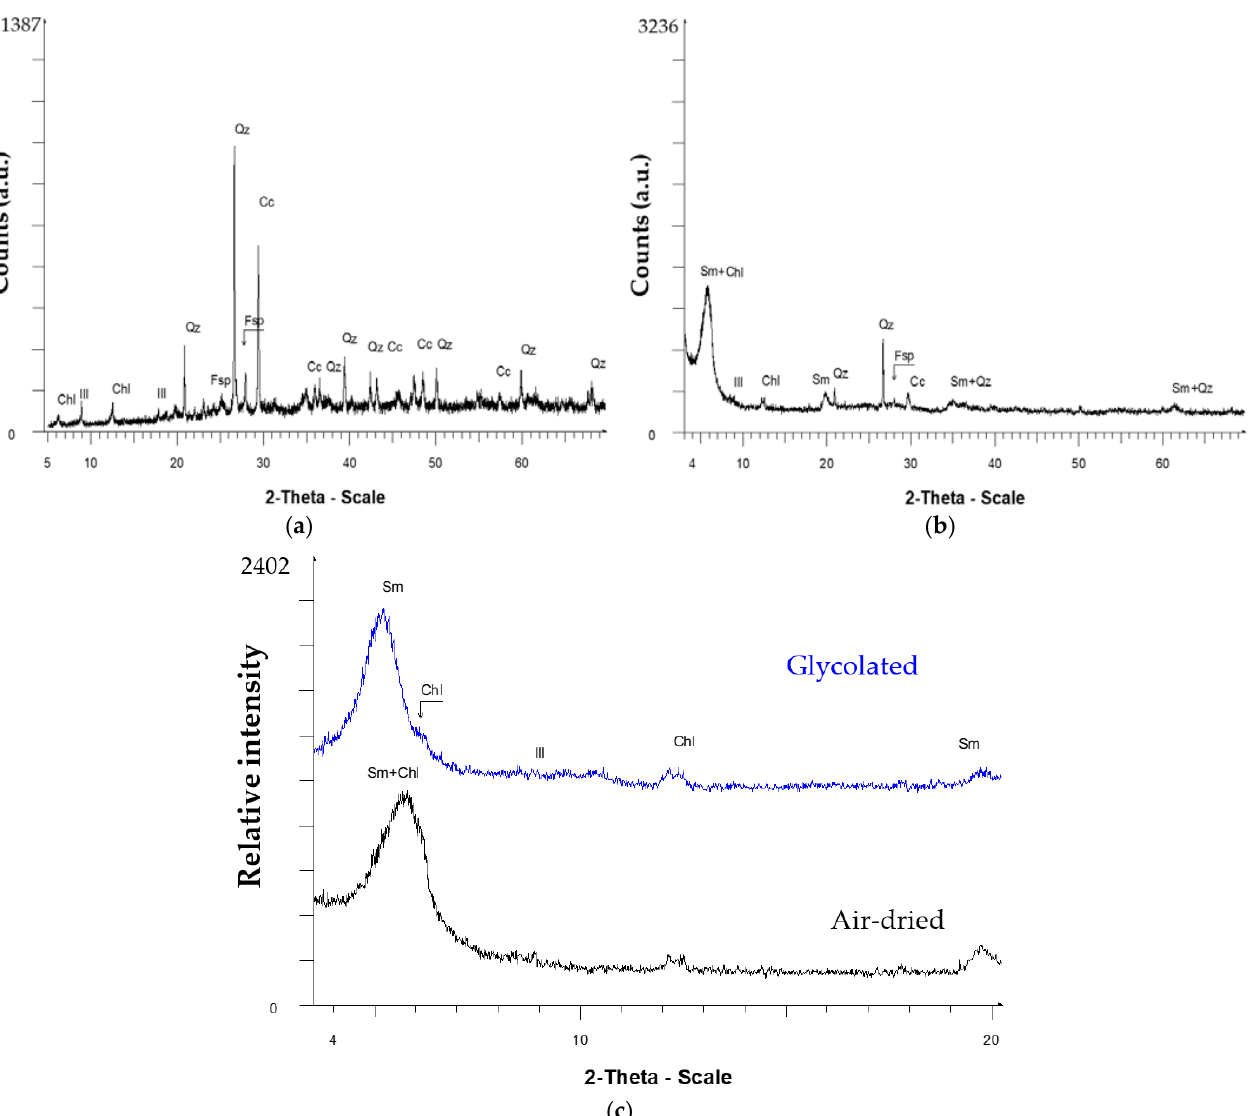
Figure 2. Powder X-ray diffraction patterns of the ( a ) clay-body (W), ( b ) clayey overburden sterile (CSM), and ( c ) clay fraction of CS. Abbreviations: Cc—calcite; Chl—chlorite; Fsp—feldspar; Ill—illite; Sm—smectite, Qz—quartz.